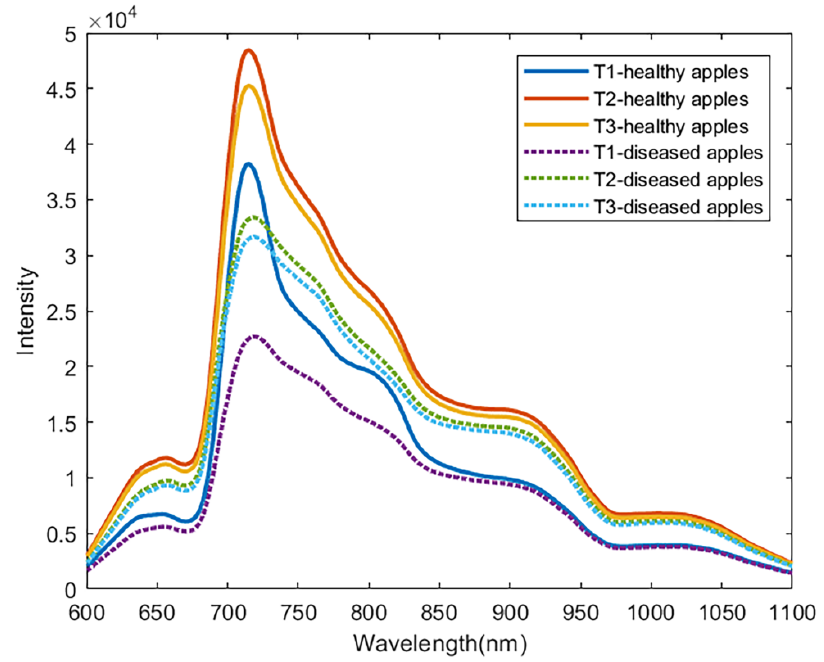
Figure 8. Mean spectrum data of healthy and diseased apples in three orientations.